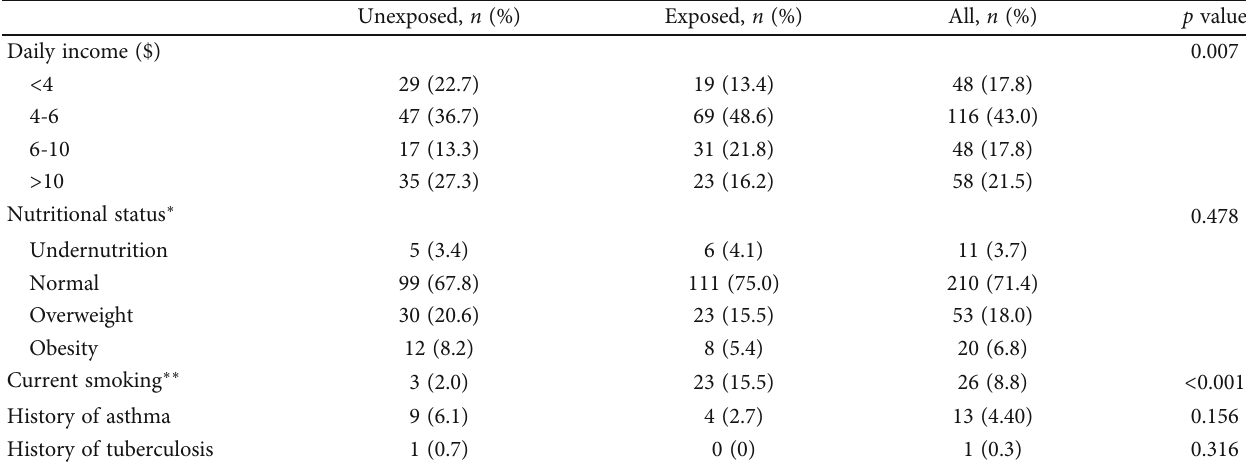
Table 2: Comparative baseline characteristic of e-waste workers in informal recycling sector (exposed group, n = 148 ) and matched unexposed subjects ( n = 148 ) in Cotonou, Benin ( N = 296 ).